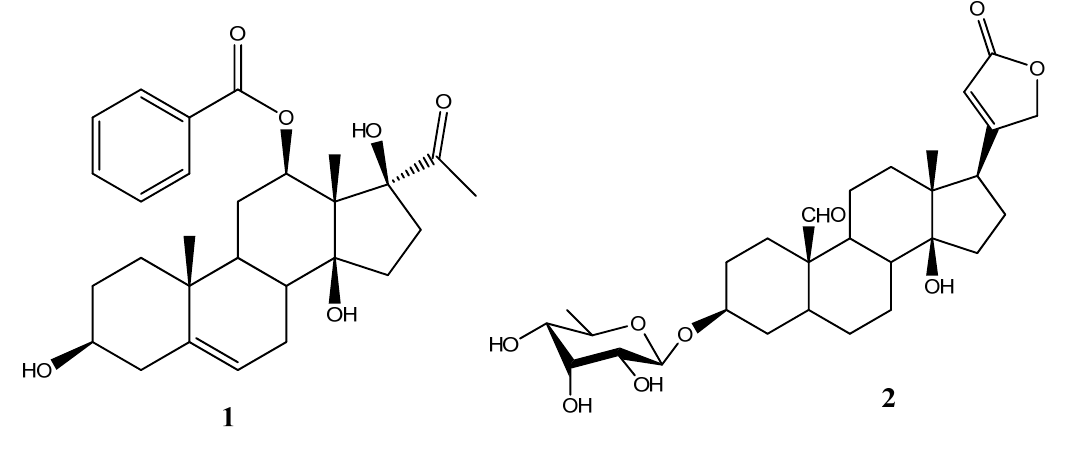
Figure 1 . Structures of Compounds 1 and 2